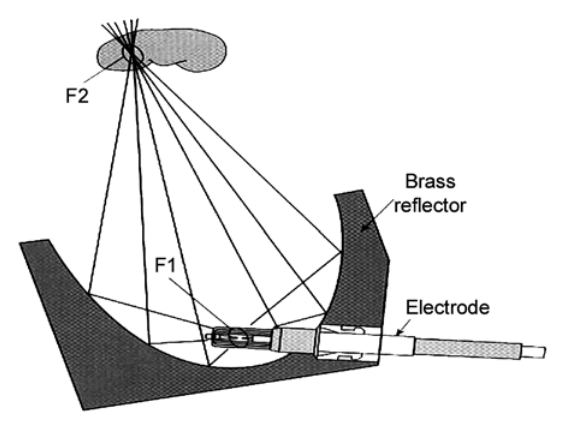
Figure 1 – Shockwave focus